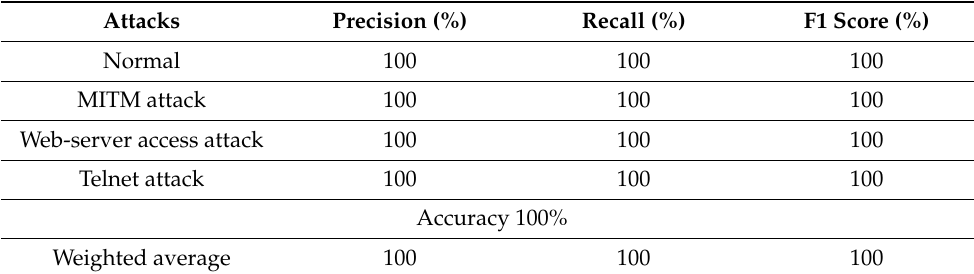
Table 9. Results of the KNN approach using the multiclass classification